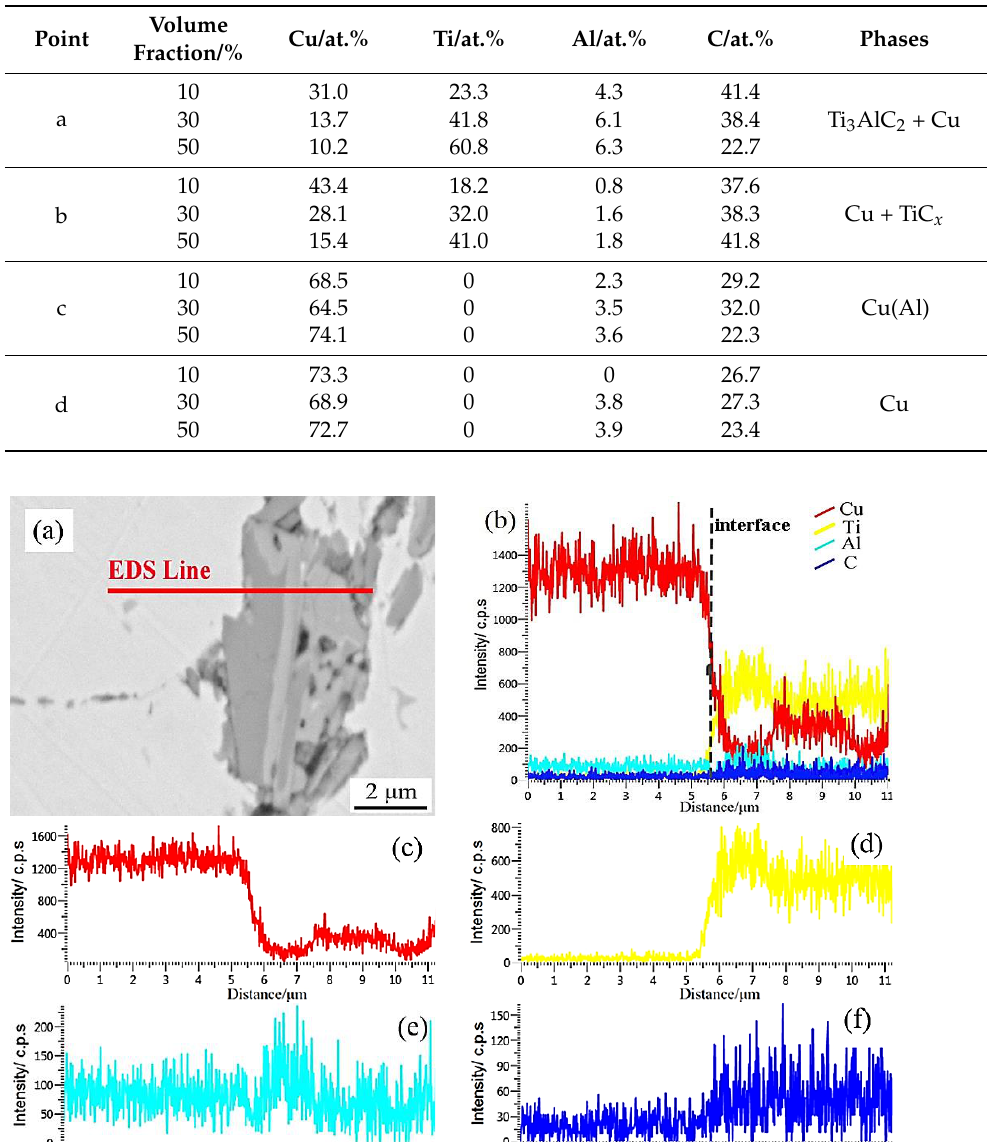
Table 1. EDS pointing results of Ti 3 AlC 2 /Cu composites.